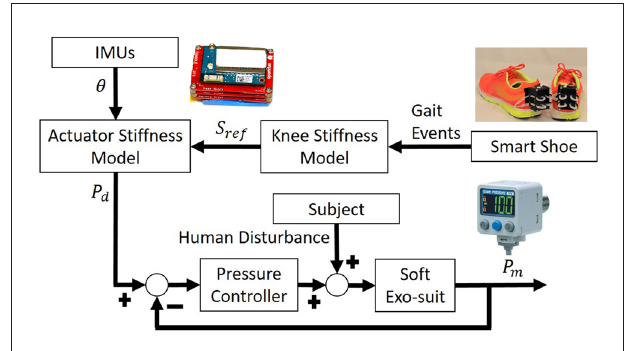
Figure 4 | Control scheme of the soft exosuit. Measurements from IMUs and smart shoe are provided as an input to the actuator stiffness model to generate desired pressure set points. A low level pressure control loop is designed to drive the actuator to the pressure set